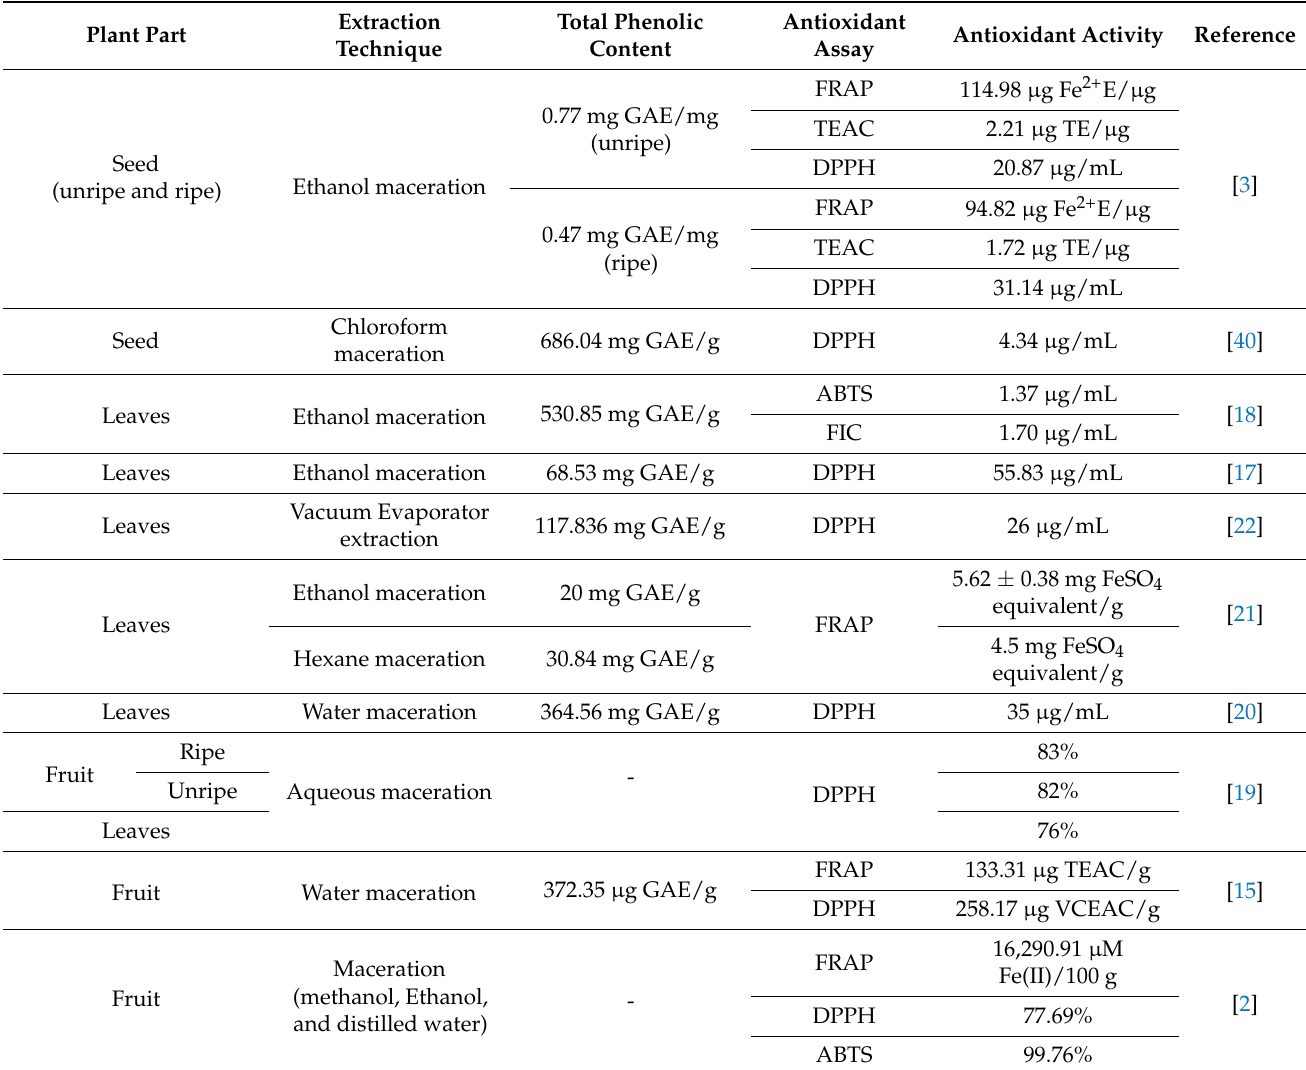
Table 1. Antioxidant Activity of B. macrophylla